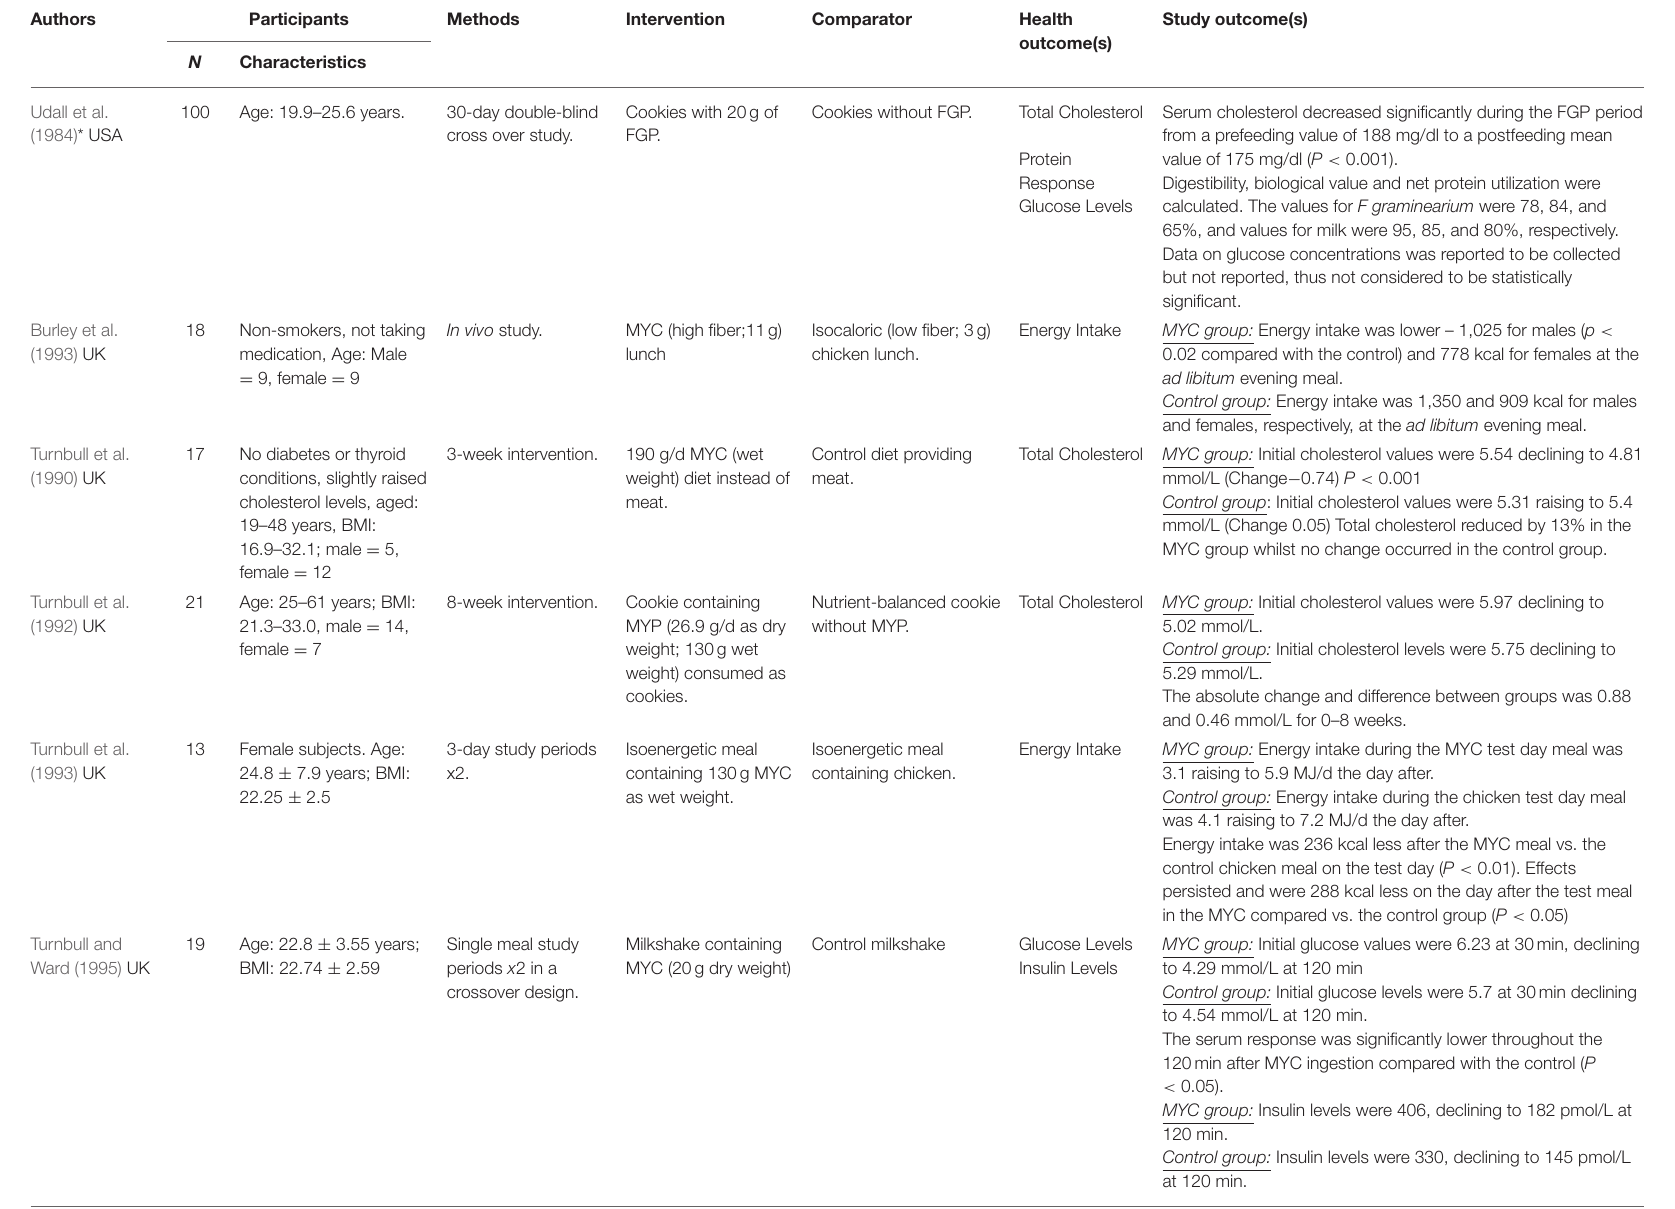
TABLE 3 | Fungal protein (mycoprotein) and health: human